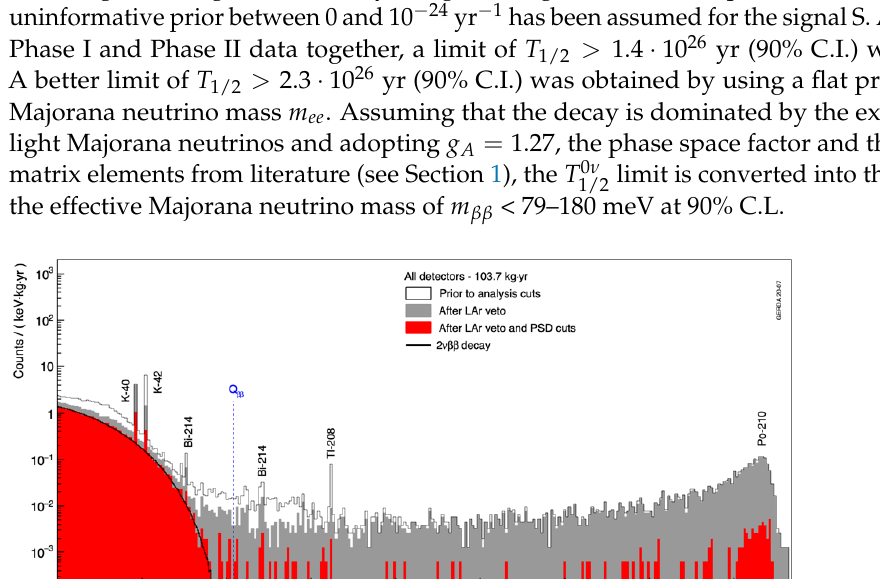
Background best fit and 68% C.L. interval